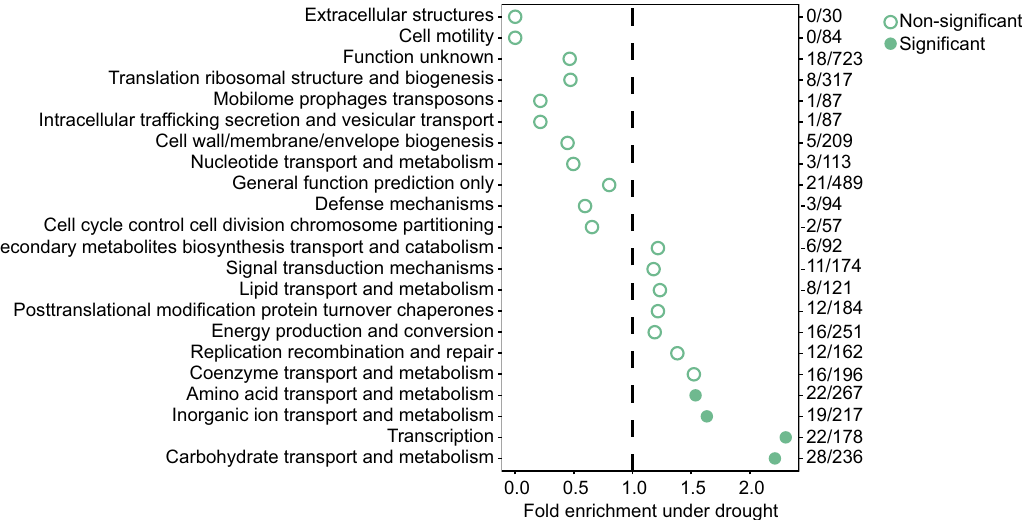
Fig. 4 GO enrichment analysis of enriched Actinobacterial metagenome-assembled genomes (MAGs) at the peak of drought in the rhizosphere. GO enrichment analysis for all COGs showing enrichment within genomes of enriched Actinobacterial MAGs ( n = 10) as compared with nonenriched Actinobacterial MAGs ( n = 5) under drought for rhizosphere at time point 8 (TP8). The values on the x -axis indicate the fold enrichment ratio of the relative percentages of COGs upregulated under drought in each category relative to the total relative percentage of COGs in the corresponding category within the entire dataset. Solid ( fi lled) circles indicate categories for which the enrichment had a p -value < 0.05 in a one-sided hypergeometric test and empty circles indicate categories with p values >